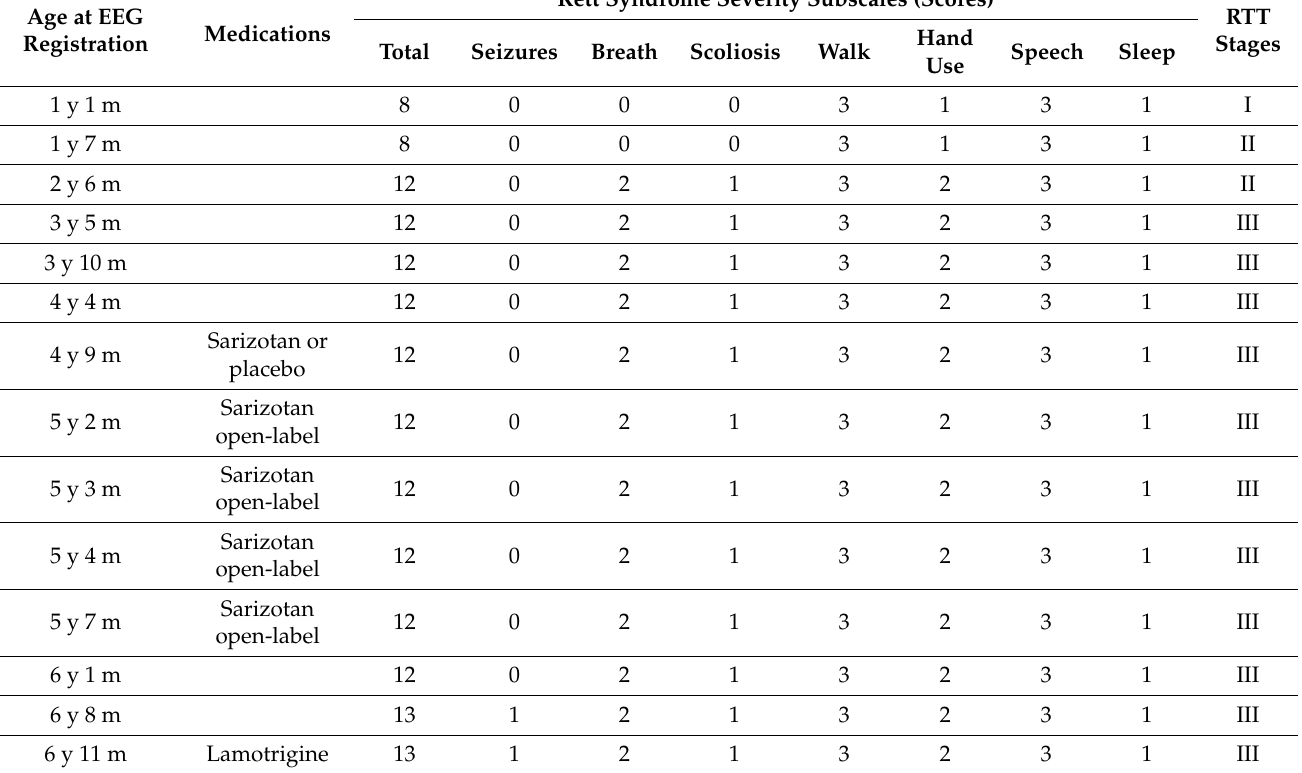
Table 1. Behavioral phenotype (Rett Syndrome Severity Subscales (RSSSs)) of patient U for corre- sponding EEG recordings. 0—no deficit, 3—severely affected with exact characteristics specific to particular